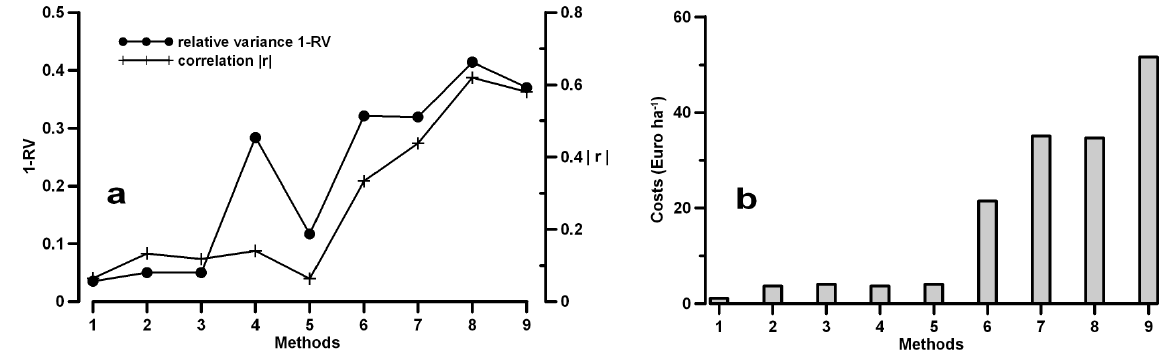
Fig. 2. Case study 1: performance indexes and costs of the tested LE methods in relation to the level of complexity.